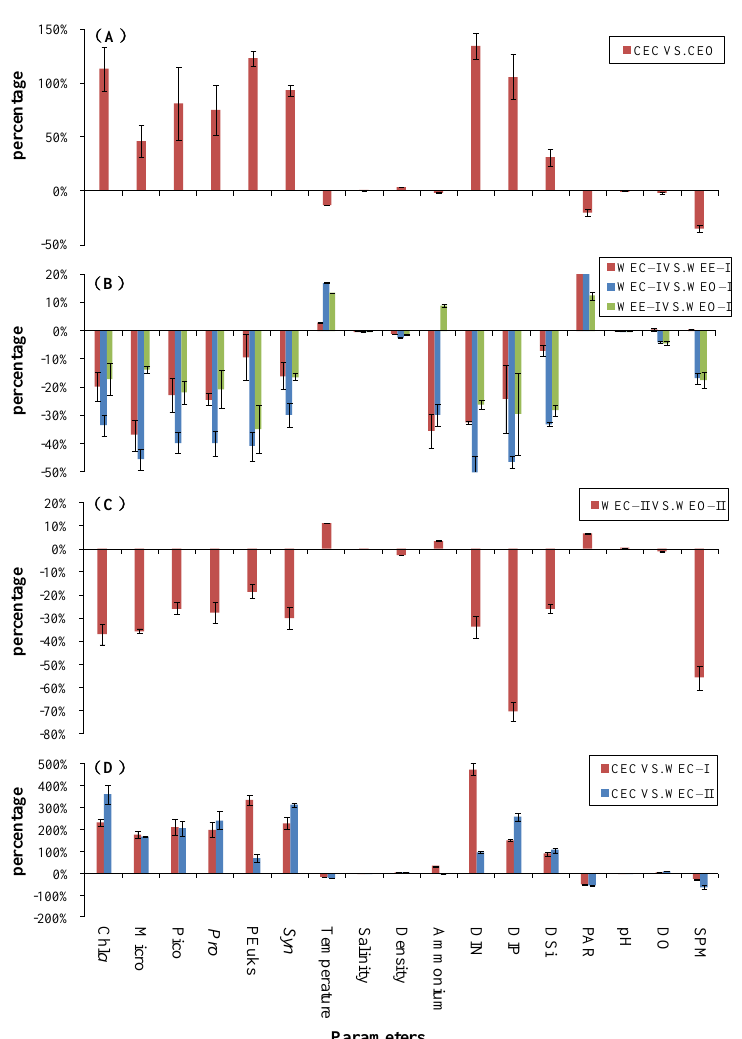
Figure 4. The percentages of increase (or decrease) of the averaged biogeochemical variables within the euphotic zone (( A ). CEC vs. CEO; ( B ). WEC–I vs. WEE—-I, WEC–I vs. WEO–I, WEE–I vs. WEO–I; ( C ). WEC–II vs. WEO–II; ( D ). CEC vs. WEC–I, CEC vs.